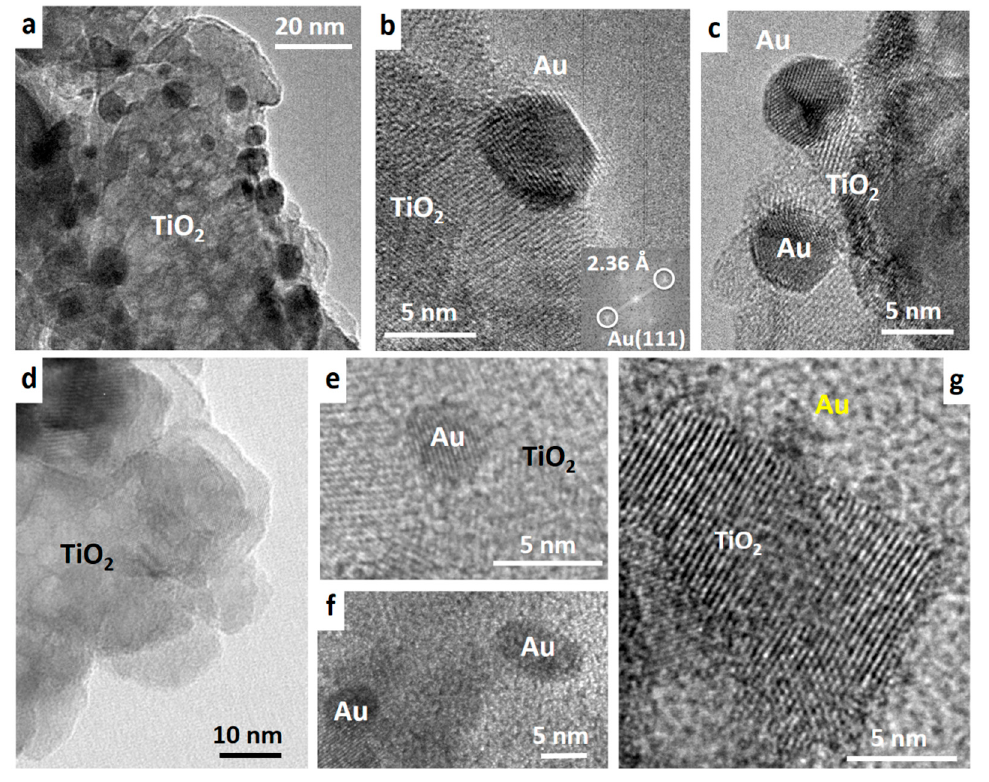
Figure 2. TEM images of ( a – c ) Au@G1/TiO 2 catalyst calcined at 673 K and ( d – g ) AuC/TiO 2 catalyst calcined at 723 K. ( b , c ) Detailed high-resolution transmission electron microscopy (HRTEM) images of individual Au@G1 NPs anchored to a TiO 2 crystallite. The corresponding FT image is shown in the inset in ( b ). ( e – g ) Detailed HRTEM image of individual AuC NPs anchored to TiO 2 .